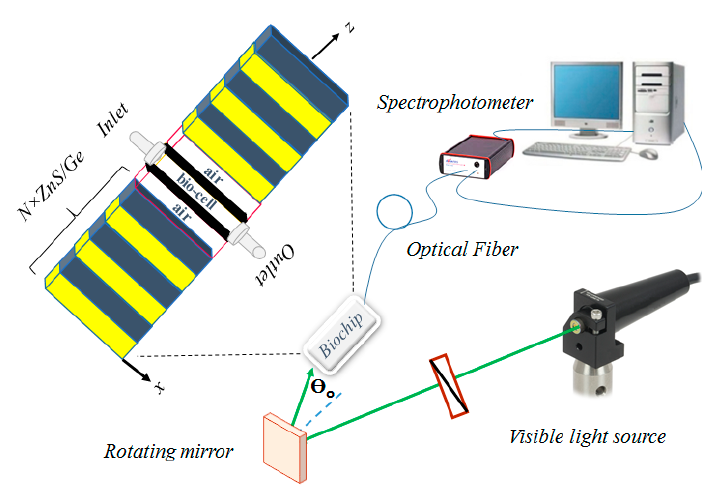
Figure 1. Schematic sketch of the suggested bio-chip and the involved parts in sensing procedures .